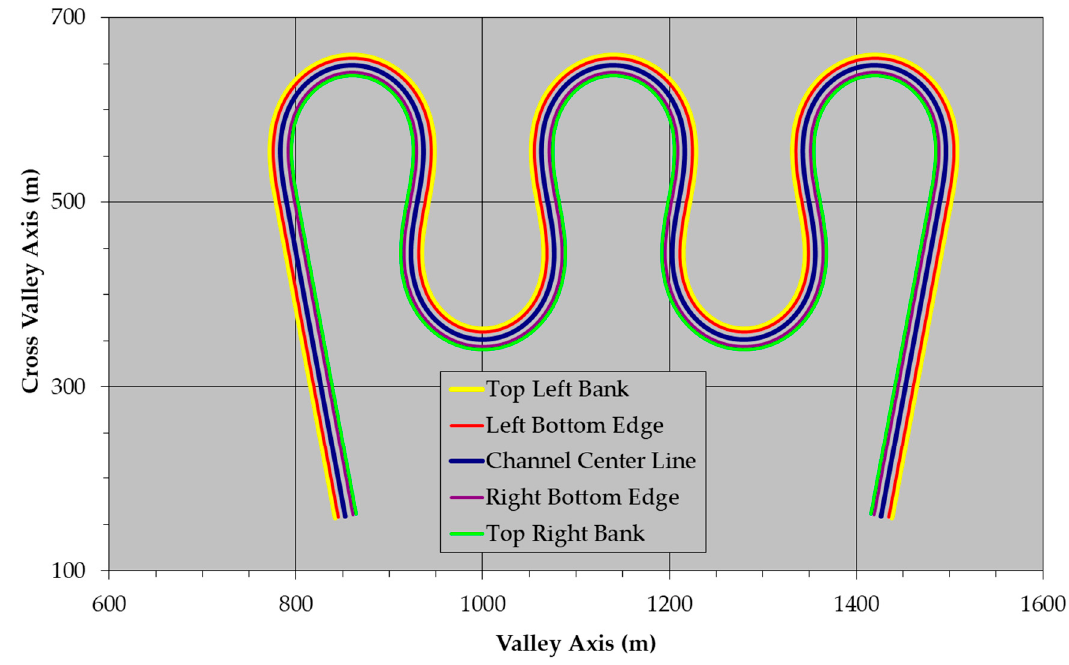
Figure 5. Example meandering river channel alignment, generated using a sine-generated curve, for Simulation Set 5 with a sinuosity of 2.75 and five consecutive curves. The upstream and downstream segments of the synthetic channel are straight and 15 channel widths long.